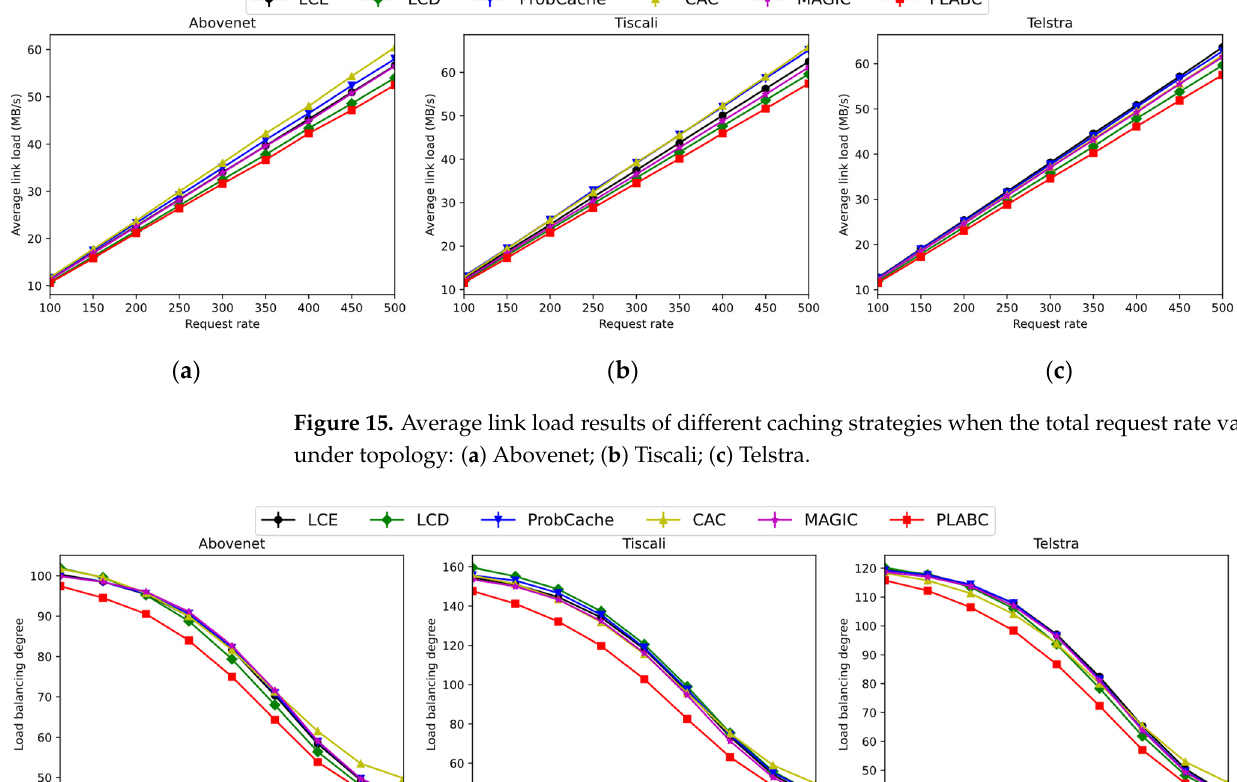
Figure 15. Average link load results of different caching strategies when the total request rate varies